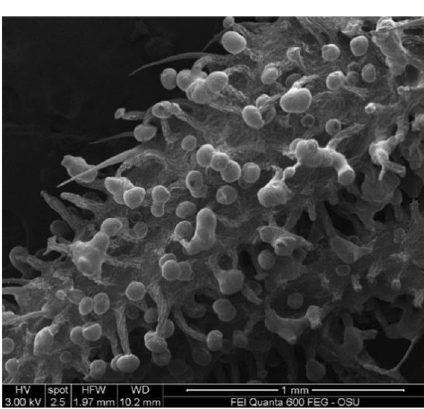
Figure 2. Non-extracted Red Bordeaux flower part with glandular